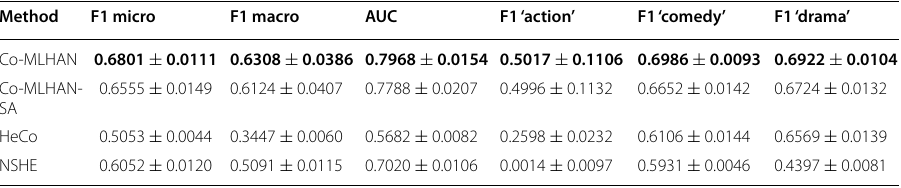
Bold values refer to the best score for each criterion